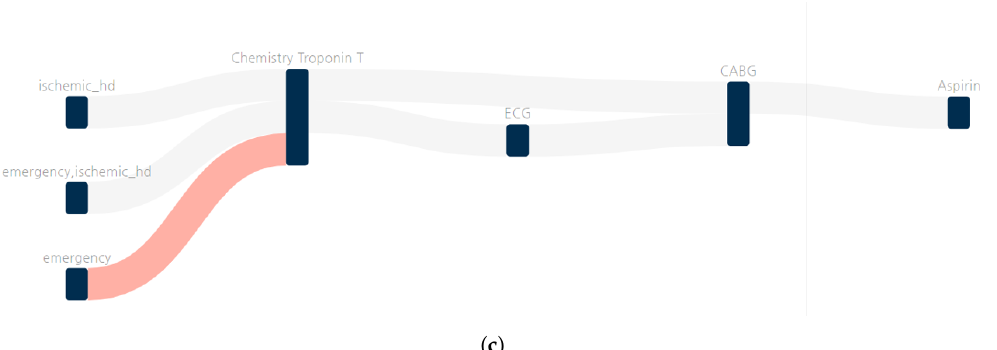
Figure 3. Example of a clinical pathway. ( a ) Example of a flowchart for sequenced events. ( b ) When an event is selected in the normal order, the link is highlighted in blue, and the selected card is displayed below. ( c ) When the event is selected in reverse order, it is highlighted in red, and the selected card is not